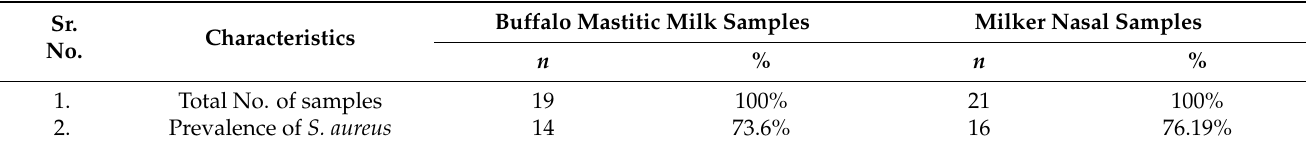
Table 4. Prevalence of S. aureus in mastitic milk and milker nasal samples.